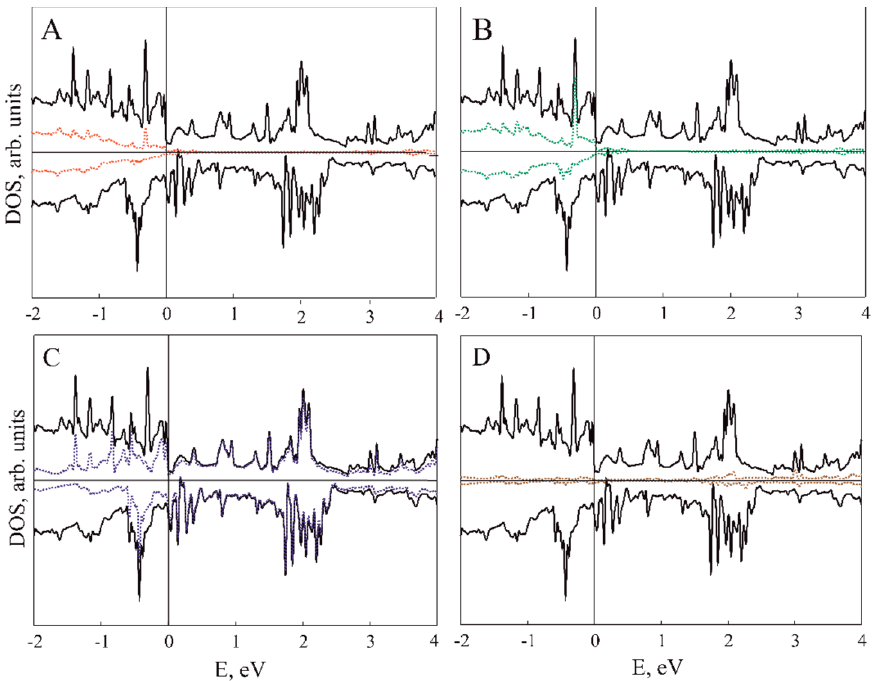
Figure 4. DOS for V 3 P 3 /ZnO composite. ( A ) Black and red lines correspond to composite TDOS and ZnO PDOS; ( B ) black and green lines correspond to composite TDOS and VP PDOS; ( С ) black and red lines correspond to TDOS of pristine ZnO slab and PDOS of ZnO fragment in V 3 P 3 /ZnO com- posite; ( D ) black and green lines correspond to TDOS of pristine V 3 P 3 slab and PDOS of VP in the composite structure, respectively.